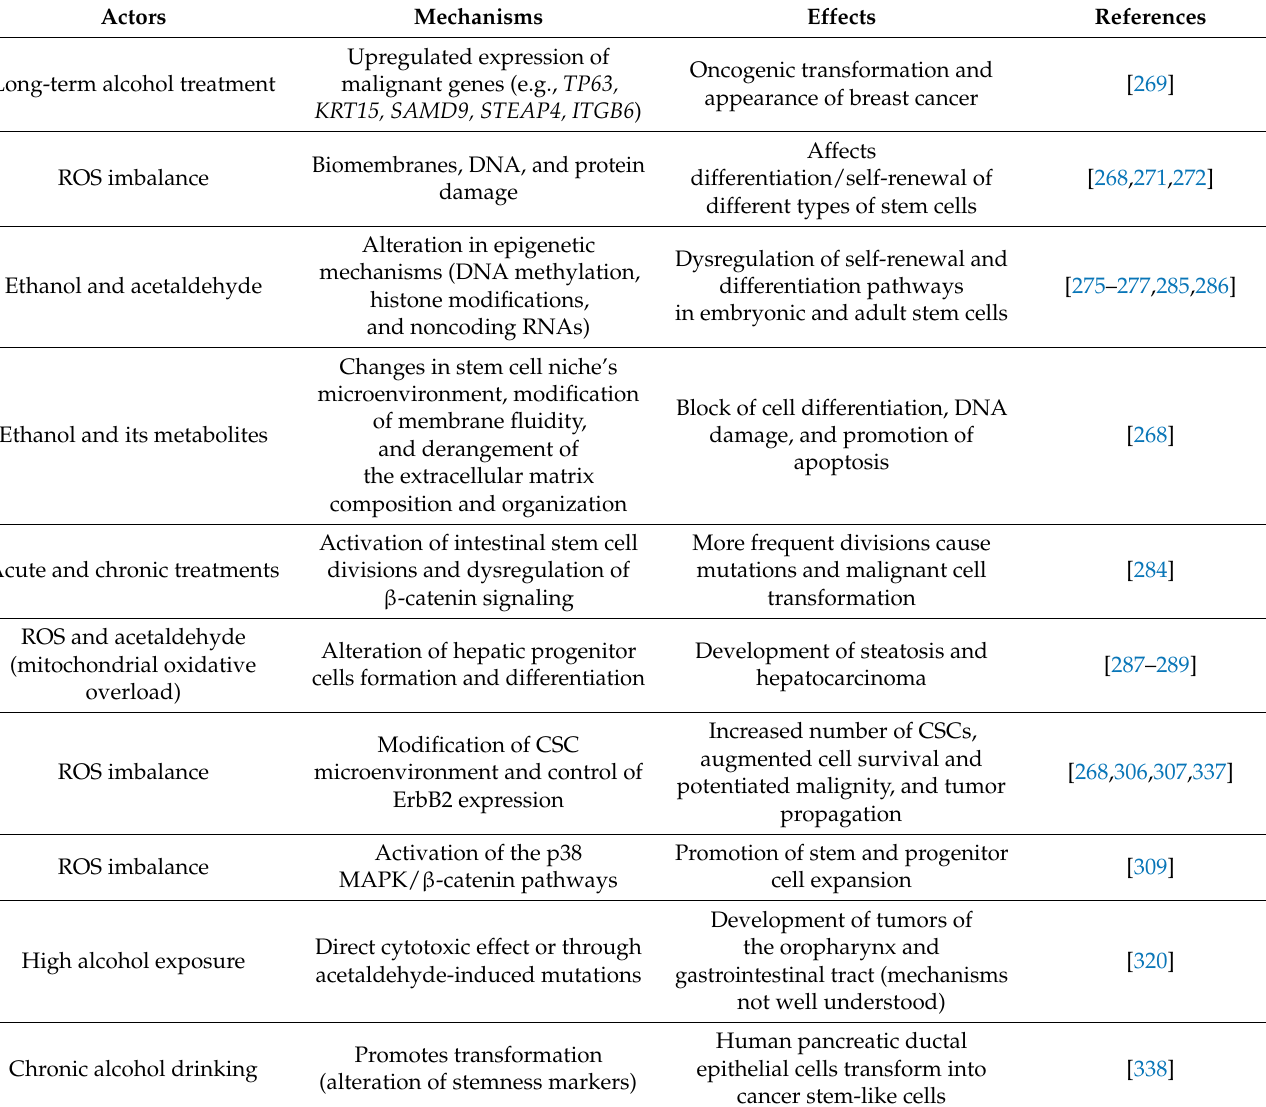
Table 3. Summary of observations that link alcohol exposure with stem and progenitor cells changes, leading to cancer development, cancer progression, and resistance to current and conventional treatments (see text for details).